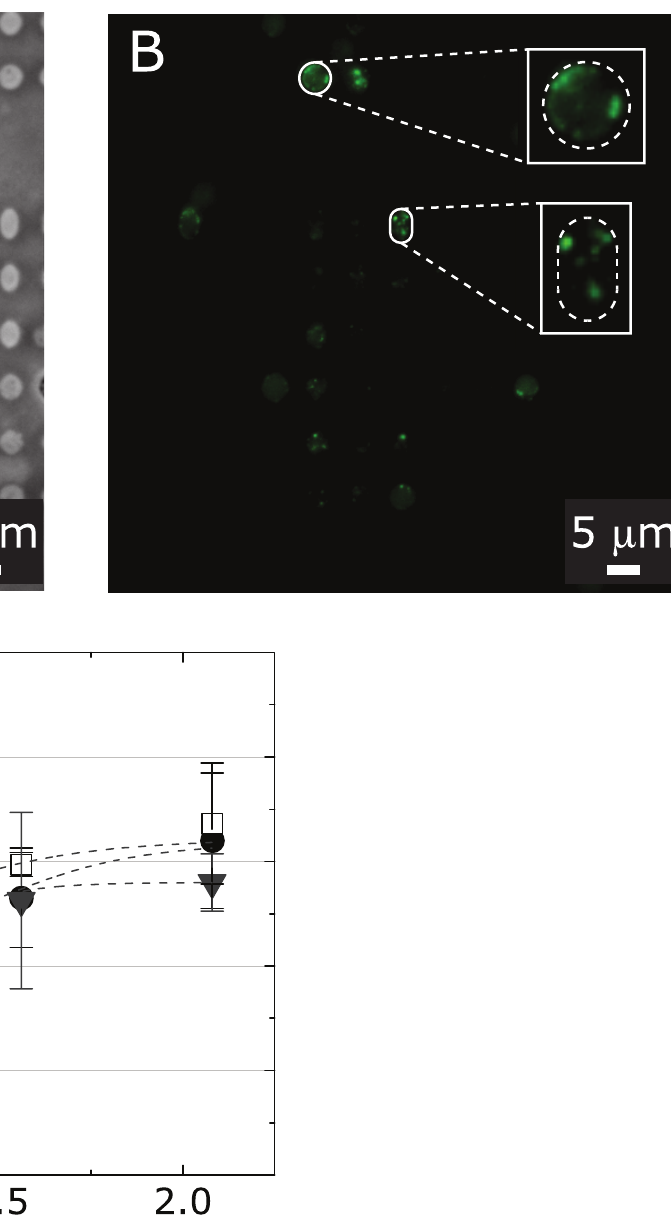
Figure S1 Determination of curvature of the micro- chambers: the contour length was marked with a 3-point